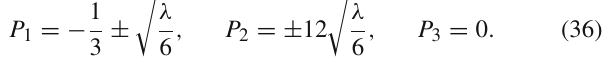
Figure 1 represents the trajectories of the phase space for different values of Table 1. From the figure the trajectories of the critical points A and C move away from the fixed points. Hence these points ( A , C ) are unstable saddle. For critical points B and D the trajectories move towards from the fixed point. So these points ( B , D ) are stable point for λ = 0 . 5. Coley [40] have investigated that the dimension of the set of eigenvalues for non-hyperbolic critical points is one equal to the number of vanishing eigenvalues. Then the set of eigen- values are normally hyperbolic and the critical points asso- ciated with it is stable but cannot be a global attractor. In our case, the set of eigenvalue is one and number of vanishing eigenvalue is also one. Hence we treat our obtained critical points as hyperbolic points. For the fixed points A and C : the density parameters are (cid:3) m = 1, (cid:3) r = 0 and the EoS parameter ω ef f = − 0 . 833 which belongs to ( − 1 , 0) shows that the phase of the Universe is in quintessence epoch and q < 0 shows that the Universe is accelerated for the region ). For these points ( A , C ), one eigenvalue( P 1 )is (0 < λ < 2 3 negative and another eigenvalue ( P 2 ) is positive whereas one eigenvalue ( P 3 ) is zero. It shows that the fixed points( A , C ) are unstable saddle. For critical points ( B , D ) : the density parameters are (cid:3) m = 1, (cid:3) r = 0 and the EoS parameter = − 0 . 166 which belongs to ( − 1 , 0) shows that the ω ef f phase of the Universe is in quintessence and q < 0 shows that ). the expansion of the Universe is accelerated for (0 < λ < 2 3 For these points ( B , D ) two eigenvalues ( P 1 , P 2 ) are nega- tive whereas one eigenvalue ( P 3 ) is zero. Thus the behavior of these points are stable. Stable and unstable fixed points for the different values of λ are shown in Table